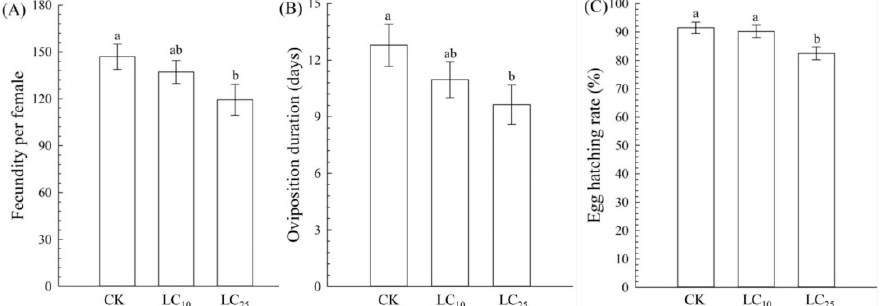
Figure 3. Sublethal effects of afidopyropen (LC 25 and LC 10 treatments) on fertility components of B. tabaci MED. ( A ) Number of eggs laid by each female. ( B ) Egg-laying days of each female. ( C ) Hatchability of eggs. CK denotes the control group and diverse letters display significant differences ( p < 0.05).